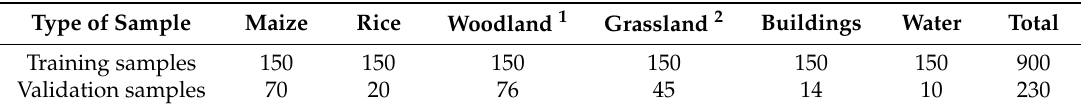
Table 1. The number of